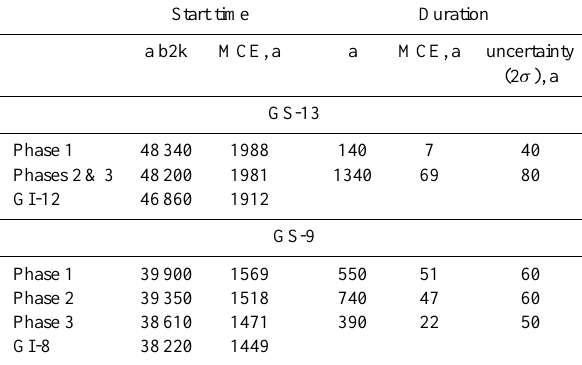
Table B1. Timing and duration of the phases identified during GS-9 in ice core proxies, on the GICC05 timescale. Column 2: onsets of GI and GS are given according to Rasmussen et al. (2014). Column 3: maximum counting error (MCE), reflecting the number of uncertain annual layers compared to year 2000 AD (Rasmussen et al., 2006, and Appendix A1). Column 5: MCE of the phase duration, calculated as the MCE difference between start and end of each phase. Column 6: total duration uncertainty for each phase: MCE of the phase duration, synchronisation uncertainty of the NEEM ice core to the NGRIP GICC05 timescale ( ∼ 20a, Rasmussen et al., 2013) and data resolution ( ± 35a in